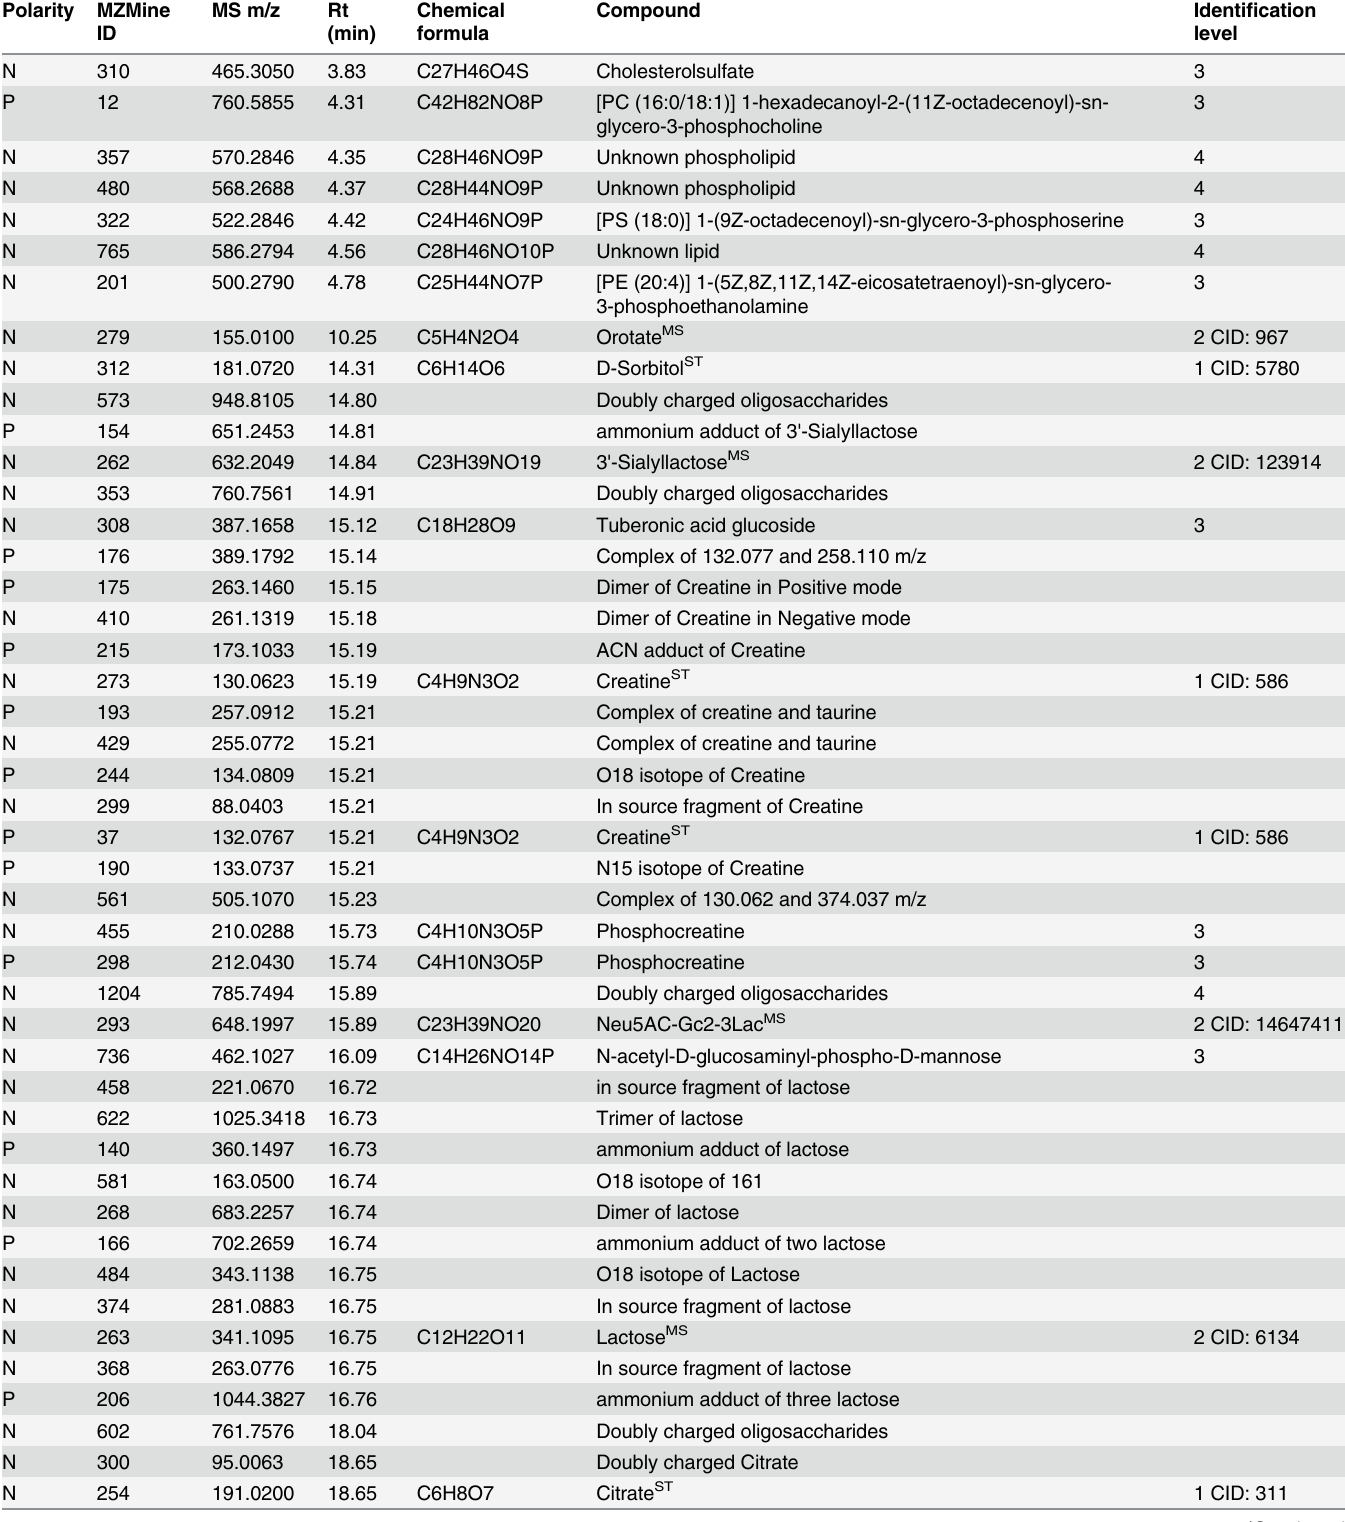
Table 1. The dominant compounds in giant panda milk in Phase 1 of early